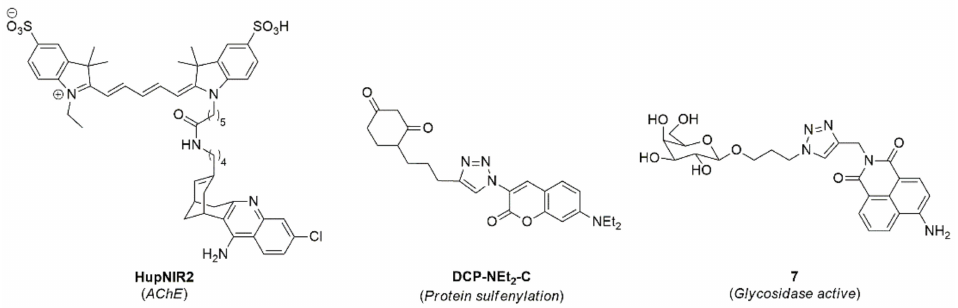
Figure 13. Organic fluorophores used for fluorescence imaging applications (shown in